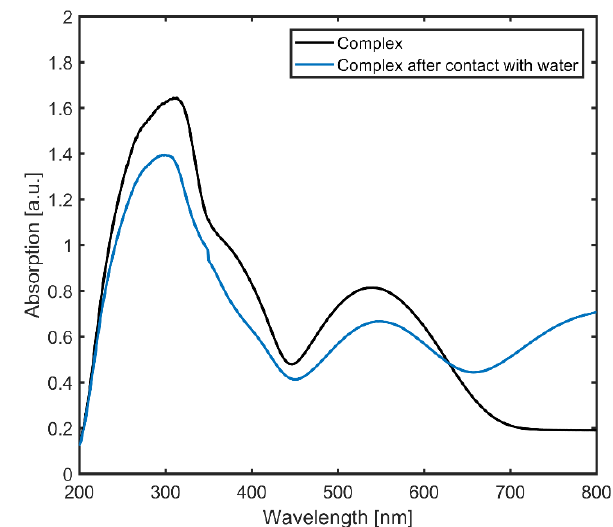
Figure 3. Solid-state UV/VIS spectrum of the [Fe(Htrz )2.85 (NH 2 -trz) 0.15 ](ClO 4 ) 2 complex.